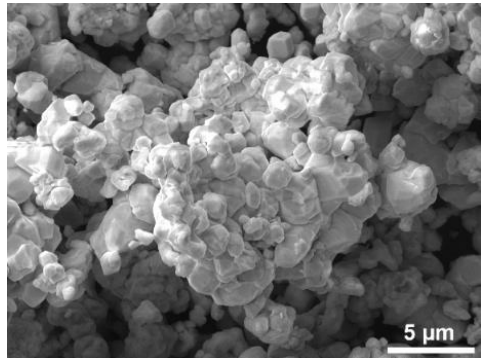
Figure 1. SEM image of original powder mixture.